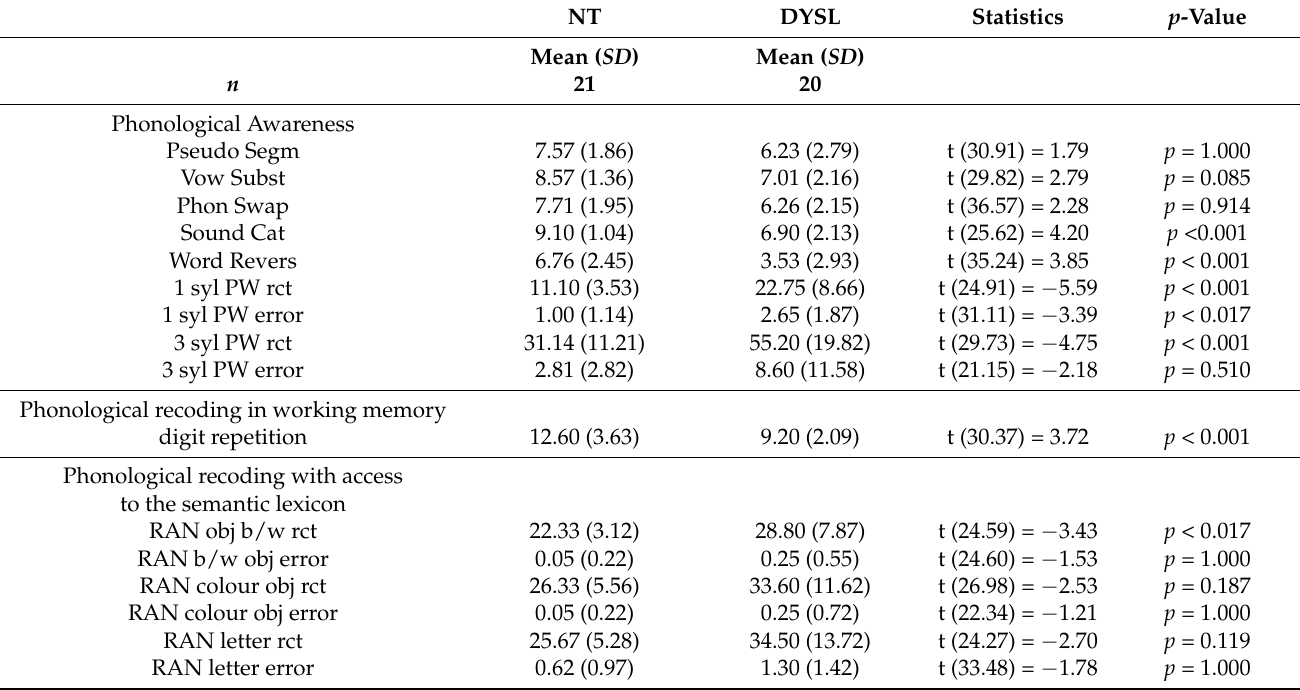
respective domain are depicted in Table 4 for phonological performance, Table 5 for auditory performance, Table 6 for visual performance, and Table 7 for cerebellar performance. Table 4. Phonological performance.